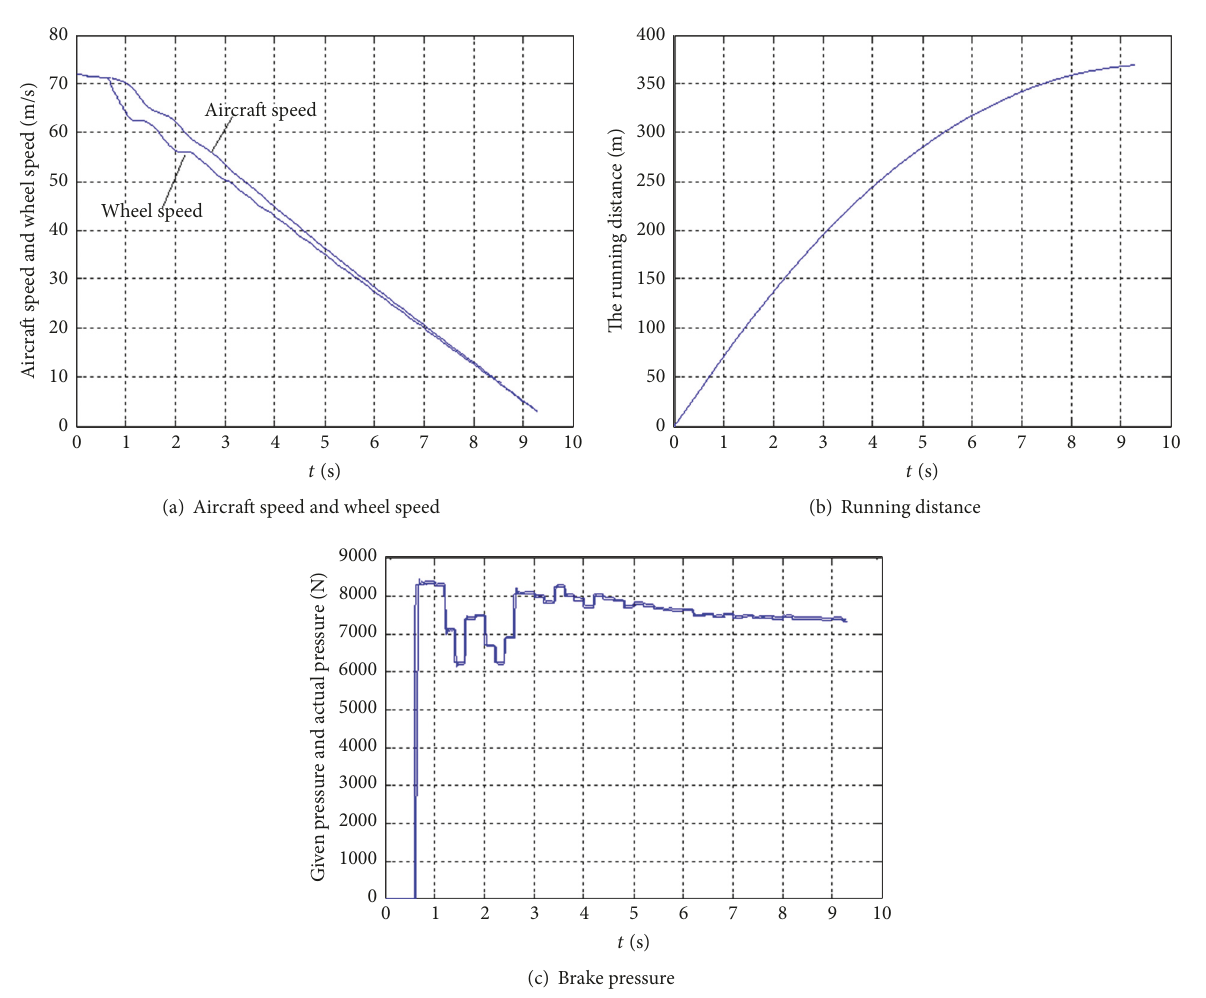
Figure 13: Simulation results in case of emergency